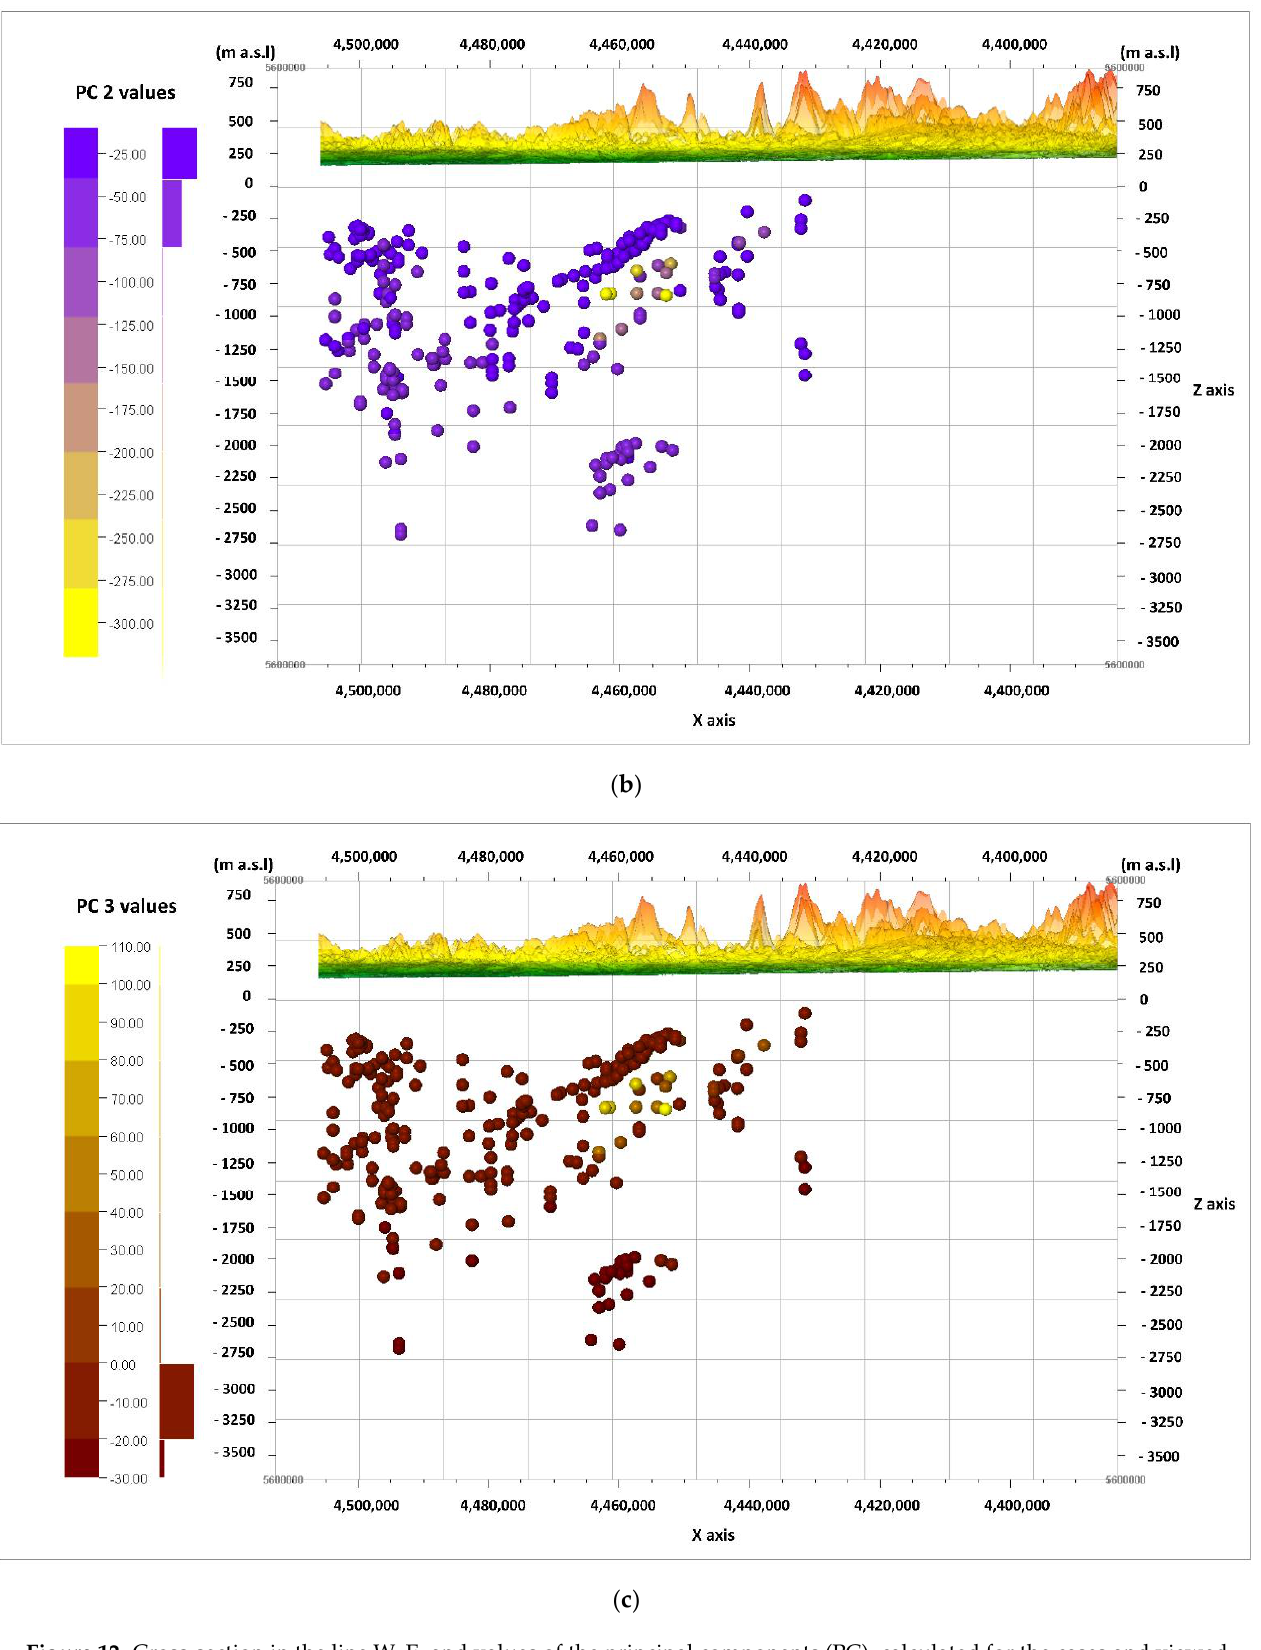
Figure 12. Cross-section in the line W–E, and values of the principal components (PC), calculated for the cases and viewed from the N. principal components: ( a ) PC 1; ( b ) PC 2; ( c ) PC 3.